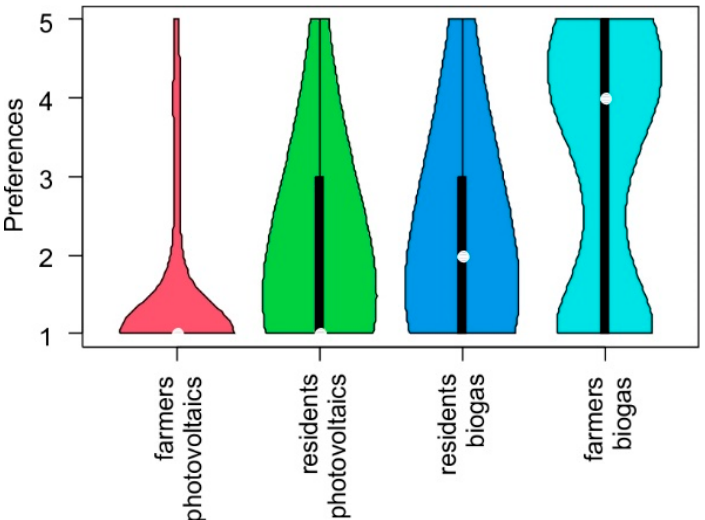
Figure 6. Preferences of local inhabitants and the degree of interest of residents and landholders in developing PV and biogas plants.